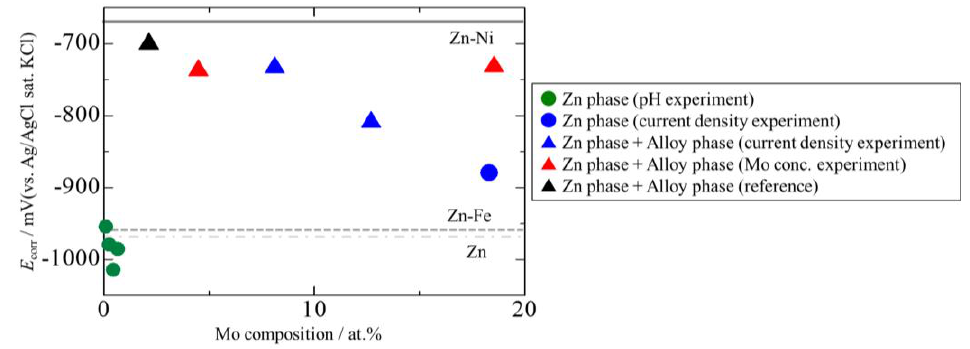
Figure 18. The relationship between the content of Mo in the plating and E corr .